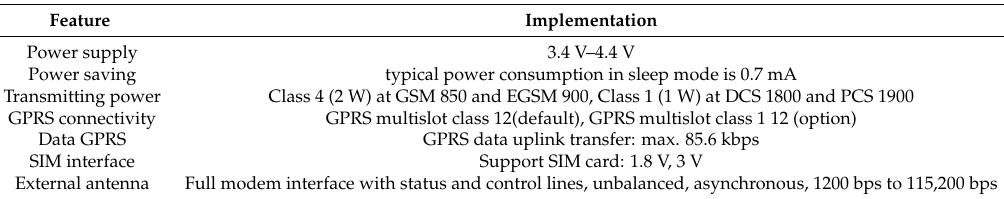
Table 1. Important GSM 800L